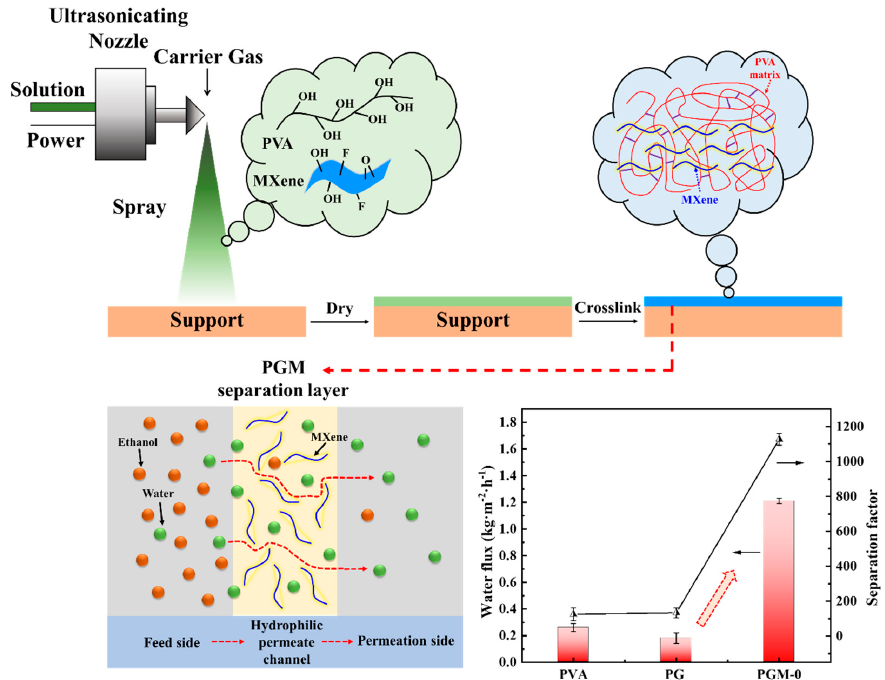
Figure 10. Fabrication of the hydrophilic permeate channels in the PVA membrane matrix and its mechanism for ethanol/water separation.